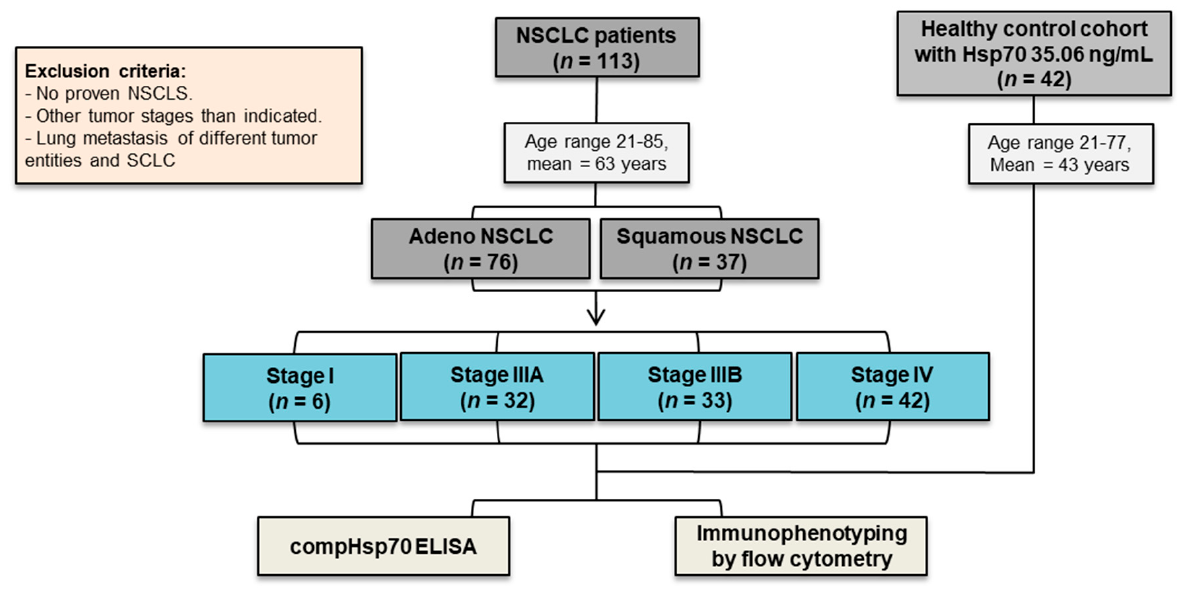
Figure 1. Schematic representation of the study. CONSORT diagram of the patient and healthy con- control trol cohorts.